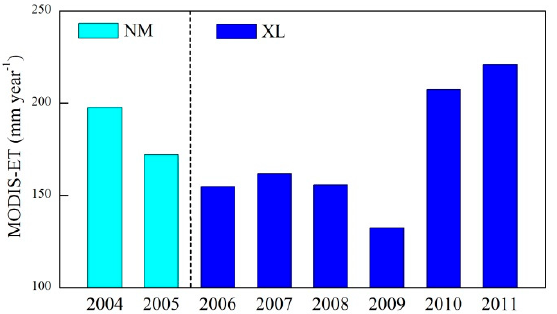
Figure 2. MODIS evapotranspiration (ET) observations for the two temperate steppe sites (NM and XL) during the growing season from 2004 to 2011.